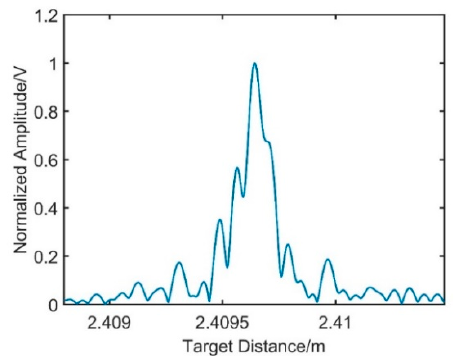
Figure 7. The distance spectrum of the resampling target spatial signal.